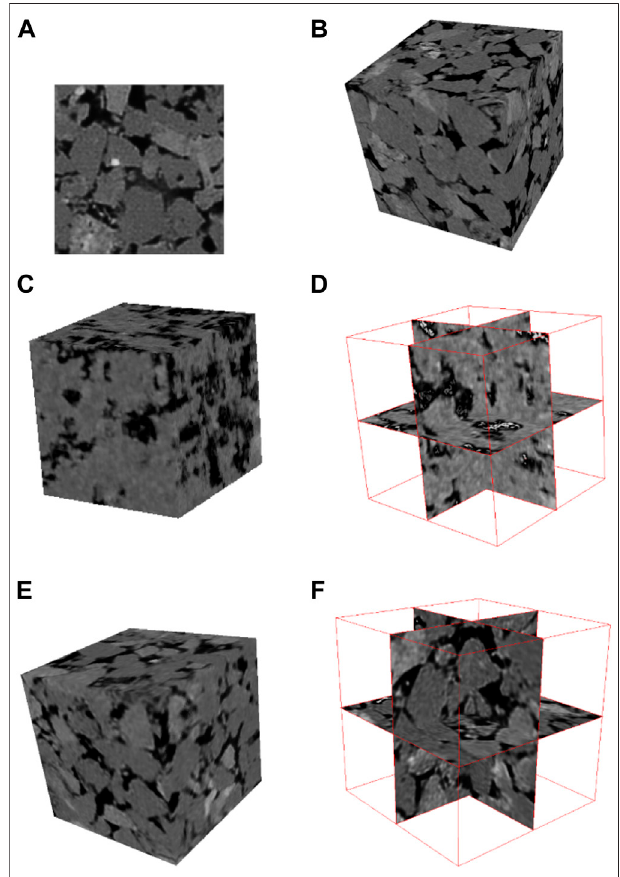
FIGURE 5 | Comparison of gray core images reconstructed by SD and CPGAN. (A) Reference image; (B) target sample; (C) SD algorithm reconstruction structure; (D) cross-section of the structure reconstructed by SD; (E) CPGAN algorithm reconstruction structure. (F) cross-section of structure reconstructed by